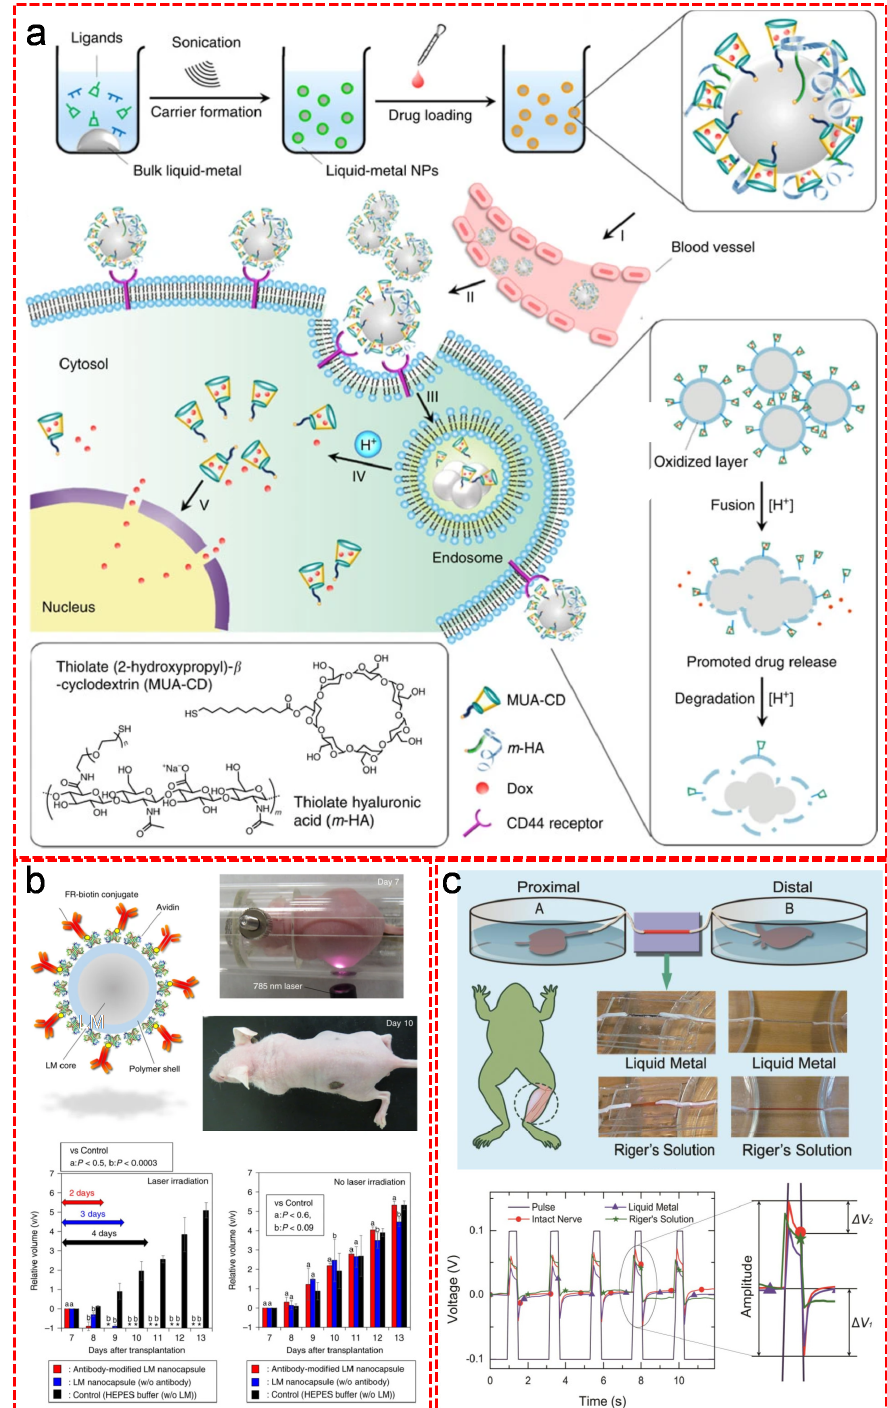
Figure 11. LM biomaterials for biomedical applications. ( a ) Schematic illustration of synthesis procedure of the transformable EGaIn nanomedicine and the working principle of drug delivery and release. Reproduced with permission. [140] Copyright 2015, Springer Nature Limited. ( b ) Functionalized LM capturing antibody for the rapid and effective tumor removal and corresponding data showing the comparison of time-dependent tumor volume change upon different types of treatment. Reproduced with permission. [151] Copyright 2017, Springer Nature Limited. ( c ) The transected sciatic nerve reconnected by the LM alloy showing a superior recovery of signal, close to that from the intact nerve. Reproduced with permission. [154] Copyright 2014, Zhang et al. (accessed on 19 July